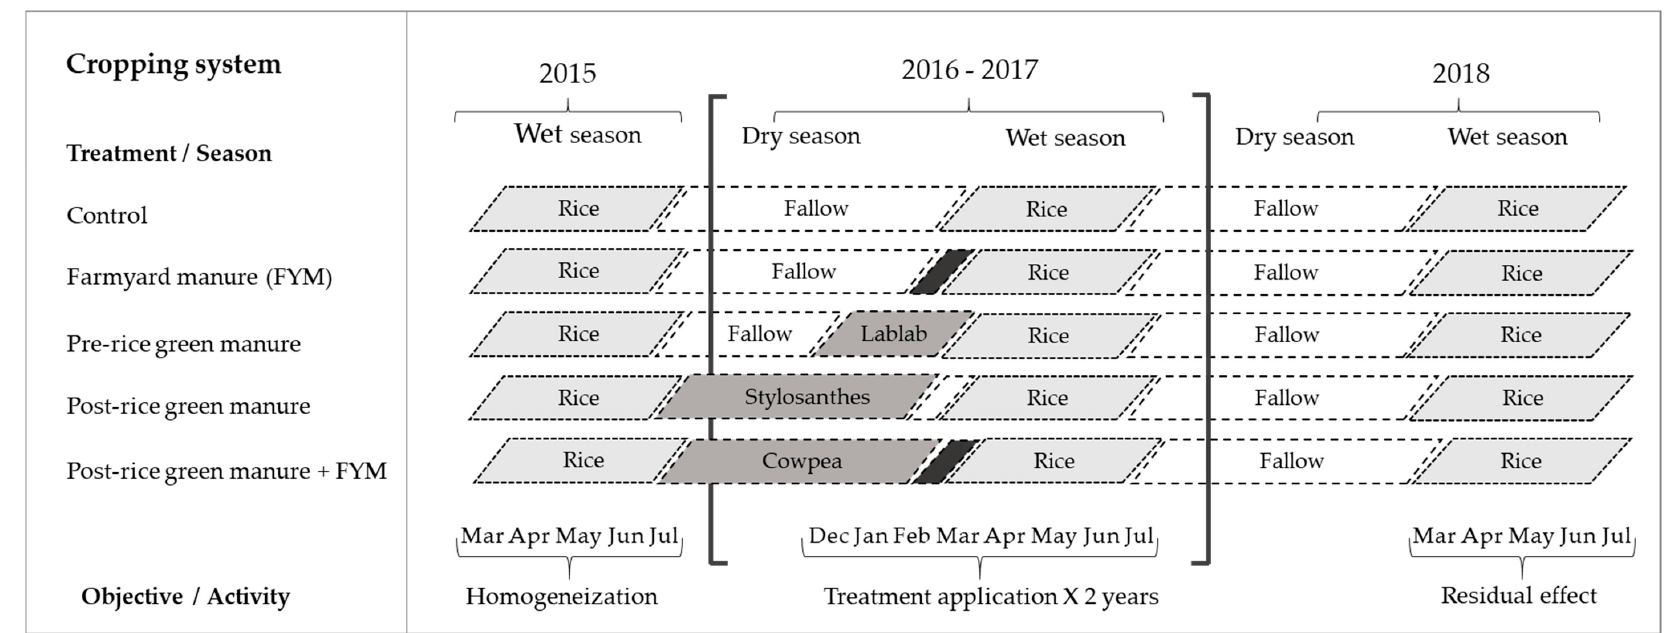
Figure 3. Characterization of the applied cropping systems, including crop species, i.e., rice, cowpea, lablab and stylosanthes, and their temporal sequence in Kilombero floodplain, Tanzania during the experimental period (2015–2018). Main rainy season extends from March to May, main dry season from July to February. Shaded black areas represent the period for farmyard manure (FYM) application.